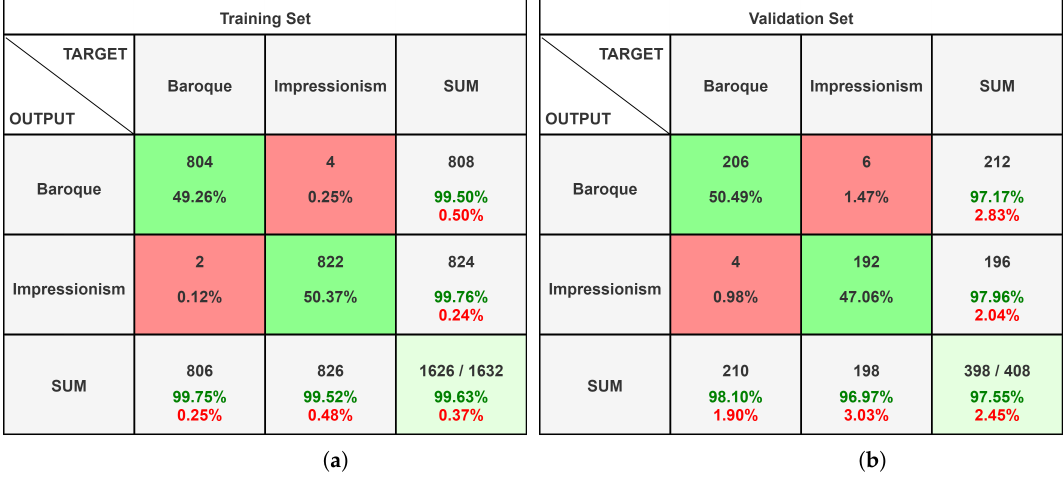
Figure 11. Confusion matrices of the paintings dataset analysed on Custom-CNN with Google Colab.